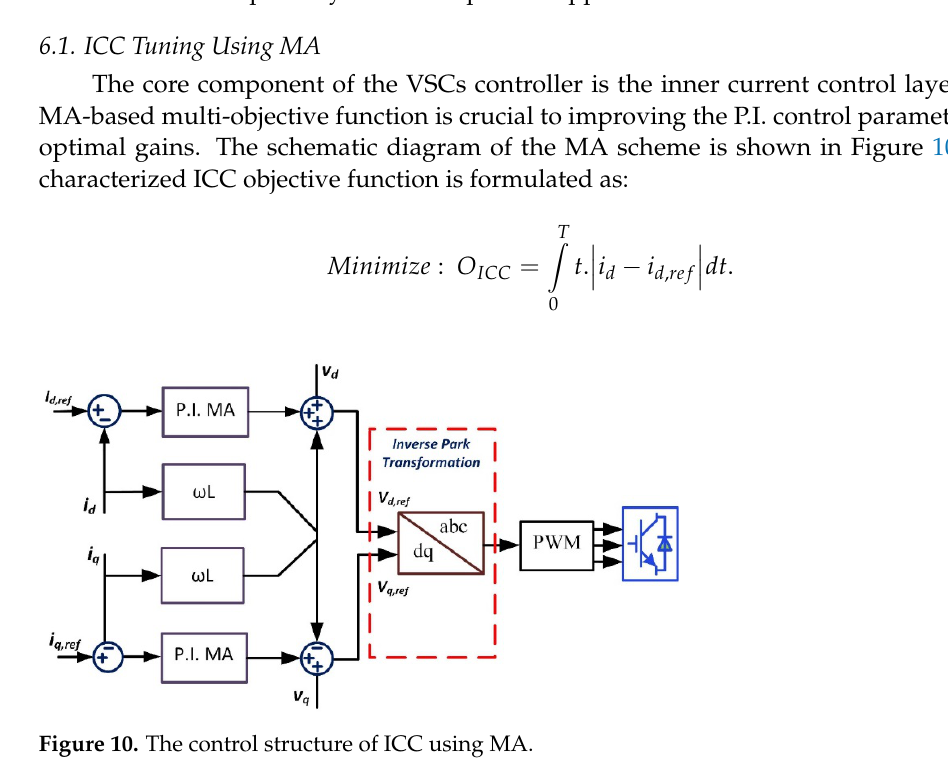
Figure 9. MA implementation of P.I. controllers .